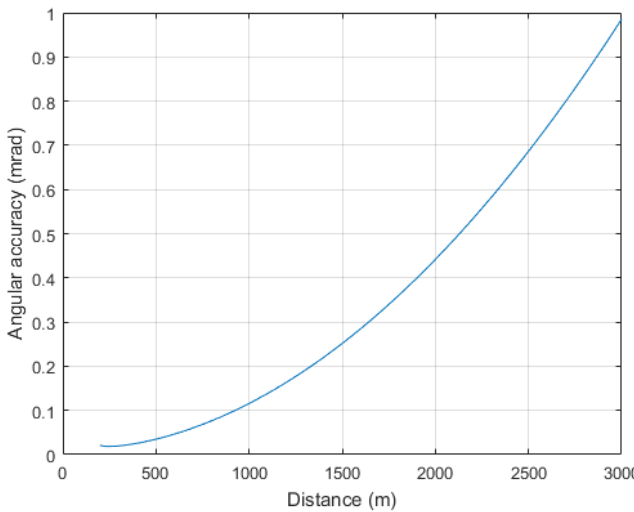
Figure 9. Angular error as a function of the distance from the